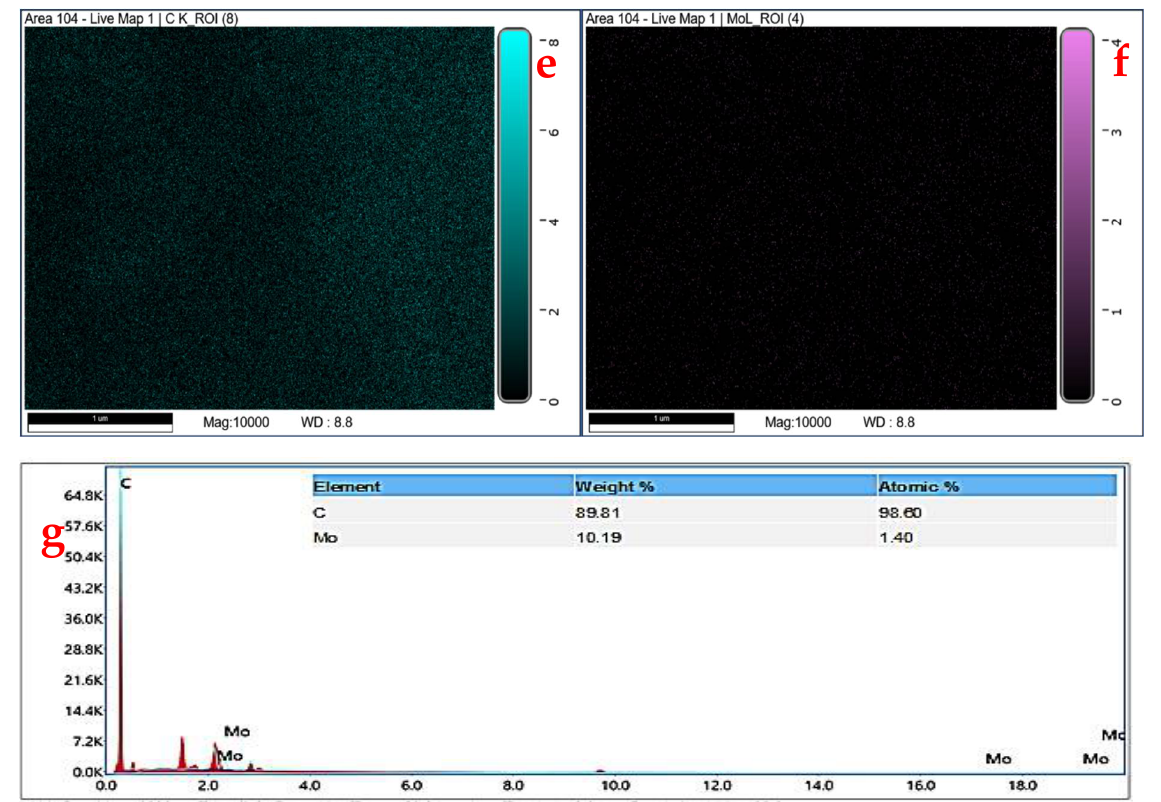
Figure 1. Scanning electron microscopy energy-dispersive X-ray spectroscopy (SEM-EDX) ( a – c , g ) and mapping images (mapping ( d ), C ( e ), Mo ( f )) of %10 Mo/CNT catalyst.